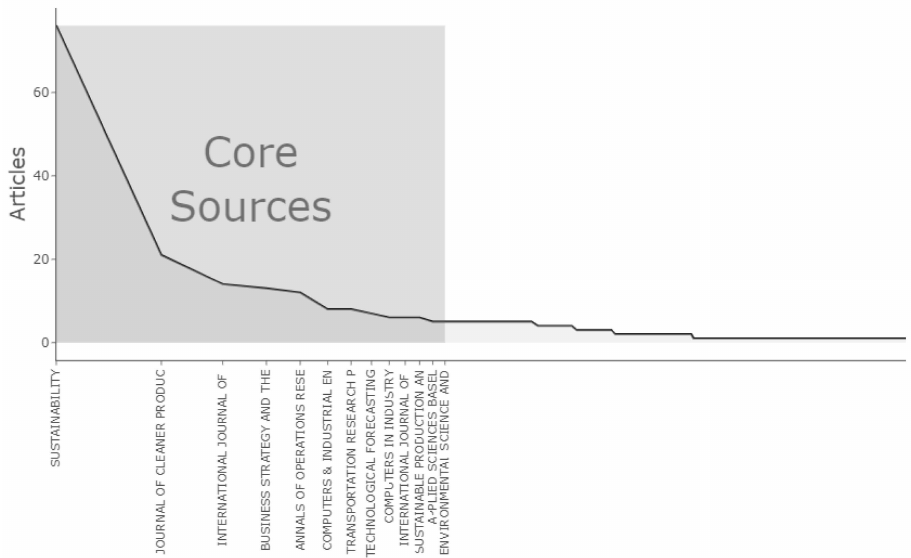
Figure 3. Source clustering through Bradford’s